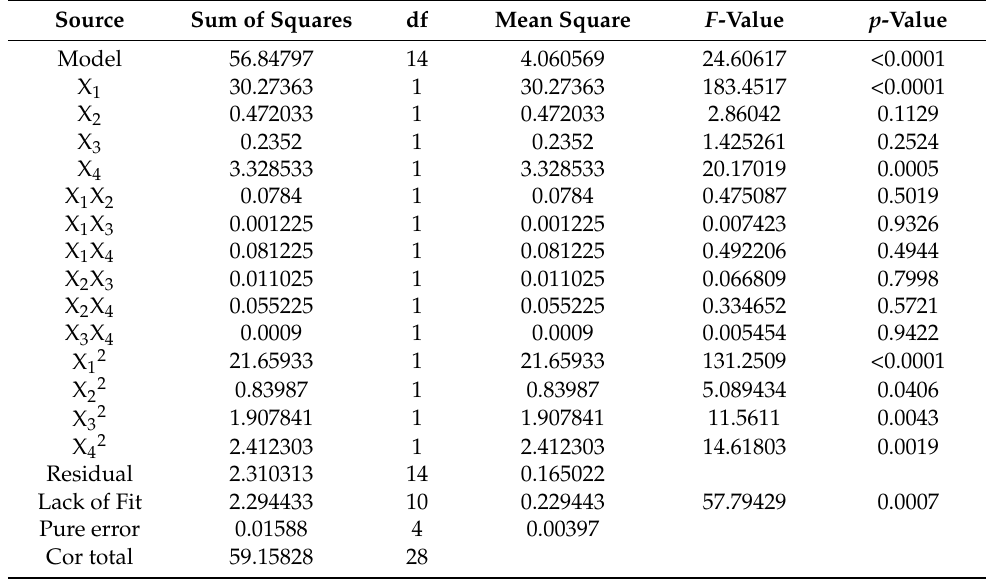
Table 5. ANOVA of the regression model for extraction yield.